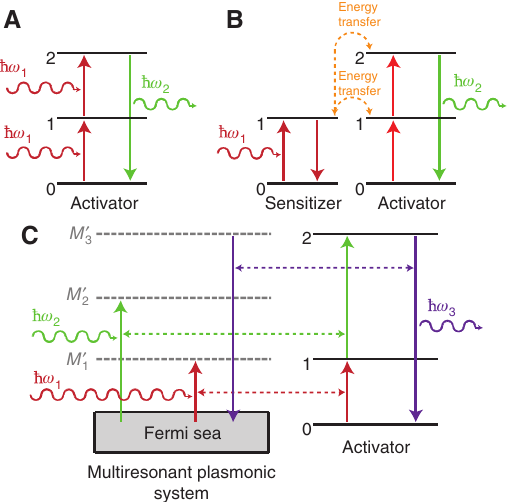
Figure 11: Energy diagram illustration of ESA and ETU UC processes and multiresonant plasmonic enhancement of ESA process by integrating a UC activator ion with a multiresonant plasmonic system with spatial mode overlap. (A) Excited state absorption (ESA) UC process, (B) energy transfer up-conversion (ETU) process, and (C) plasmon enhancement of ESA process by a multiresonant plasmonic system with spatial mode